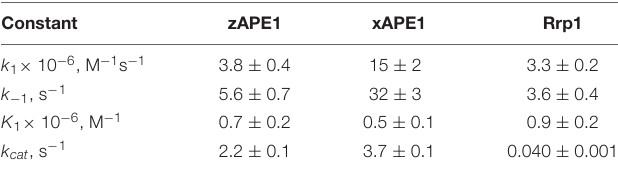
TABLE 2 | Rate and equilibrium constants of the interaction of AP endonucleases with the FRET-F-substrate.